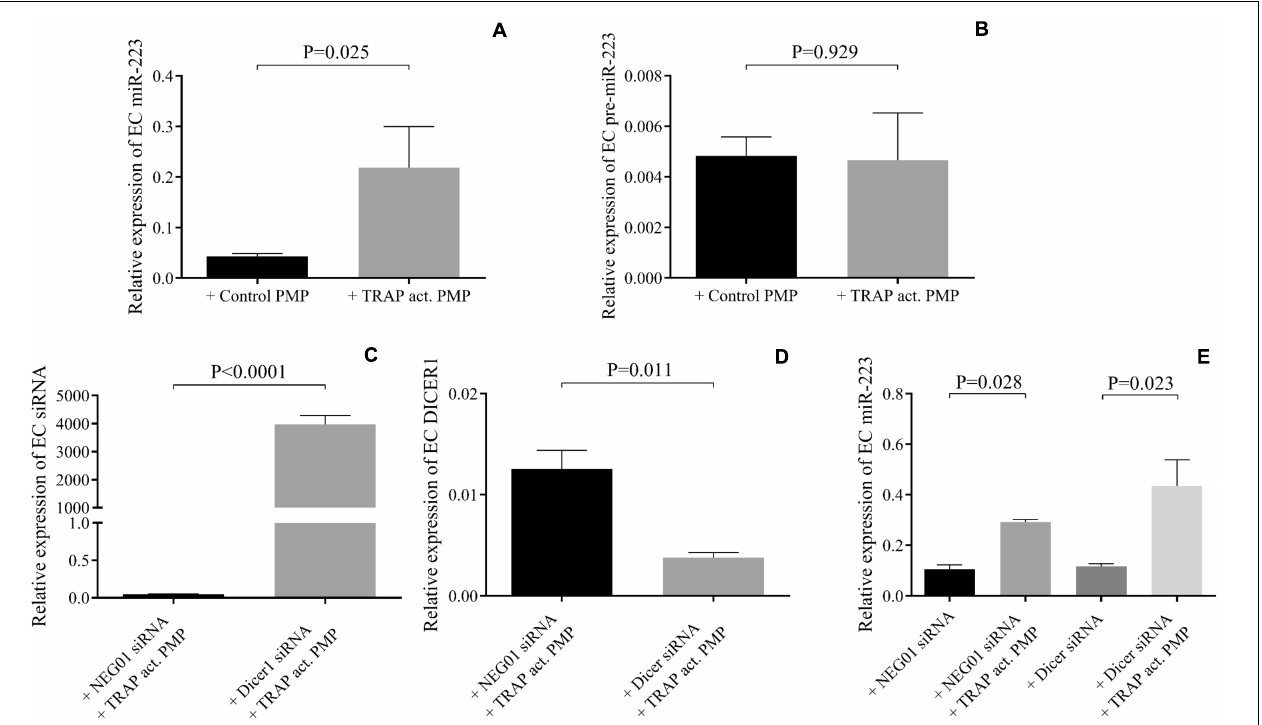
FIGURE 5 | Altered miR-223 expression induced by PMPs was not the consequence of miRNA maturation or increased Dicer1 function in HCAECs. In the presence of thrombin-receptor activating peptide (TRAP) activated platelet-derived microparticle (PMP) (gray columns) increased miR-223 expression was detected in endothelial cells (EC) similar to sepsis PMP vs. HCAECs co-cultured with non-activated control PMP (black column) (A) . No difference was observed in pre-miR-223 level with or without TRAP-induced PMP excluding the effect of transcription (B) . Dicer1 specific siRNA was successfully transfected into endothelial cells (C) that resulted in reduced level of Dicer1 mRNA (D) . Despite reduced Dicer1 expression, miR-223 level was still significantly increased in the presence of TRAP-activated PMP in endothelial cells compared to samples without PMP (E) . Similar tendency was found in HCAECs with NEG-01 siRNA (black column). These results suggested that Dicer1 activity did not contribute to upregulated miR-223 caused by PMPs. Mean ± SEM was depicted ( n = 4–5 samples/experiment). Mann-Whitney U -test or unpaired t -test was performed for